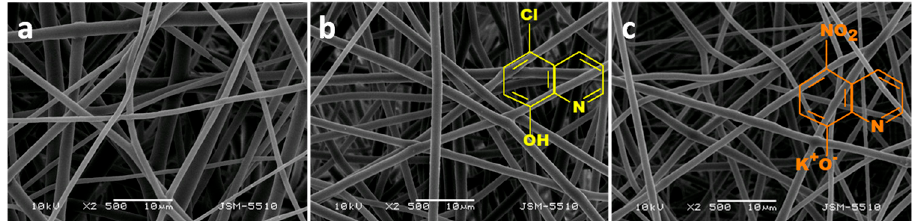
Figure 2. Representative SEM images of fibers of electrospun fibrous materials of ( a ) PLLA, ( b ) PLLA/5-Cl8Q, and ( c ) PLLA/K5N8Q; magnification ×2500 [98]. ( b ) PLLA/5-Cl8Q, and ( c ) PLLA/K5N8Q; magnification × 2500